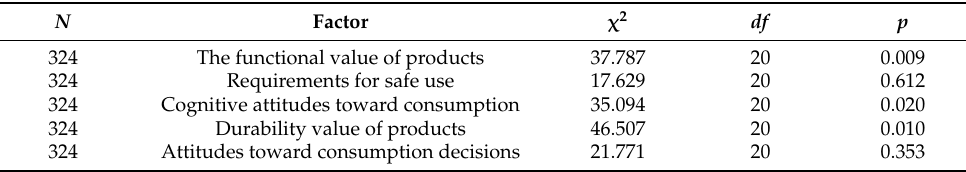
Table 13. Abstract of the Chi-square tests on the dimensions and the disposal of discarded toys. N Factor χ 2 df 324 The functional value of